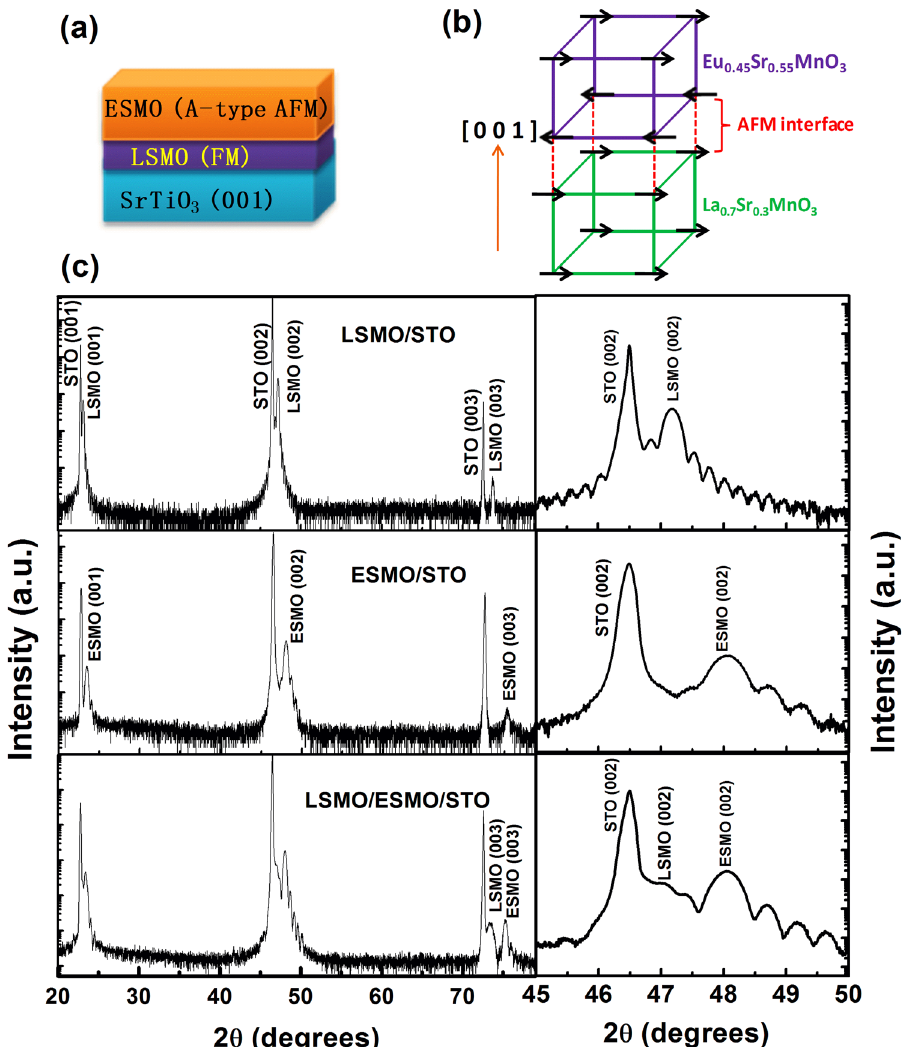
Figure 1. (a) Schematic representation of LSMO/ESMO bilayers heterostructure deposited on STO (001), (b) illustration of the lattice structure associated with simplified spin configurations in the FM-LSMO and A-type AF order in ESMO layers and the resultant interface AF arrangement, and (c) XRD- θ /2 θ normal scan for the LSMO and ESMO single layers and LSMO/ESMO bilayer, right side to ( c ) indicates the enlarged view of XRD data around the (002)